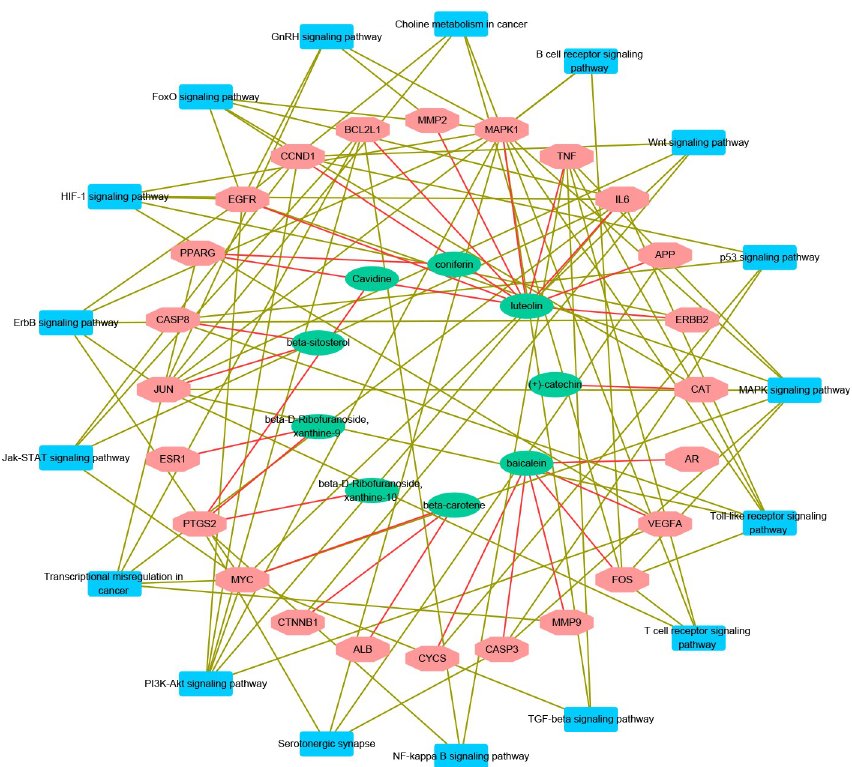
Fig 6. Compound-target-pathway networks. Green nodes stand for chemical compounds in BXHPD; Red nodes stand for known target genes from chemical compounds and depression; Blue nodes stand for the main biological pathway; Red lines stand for the relationship between compounds and target genes; Brown lines stand for the relationship between target genes and biological pathway.